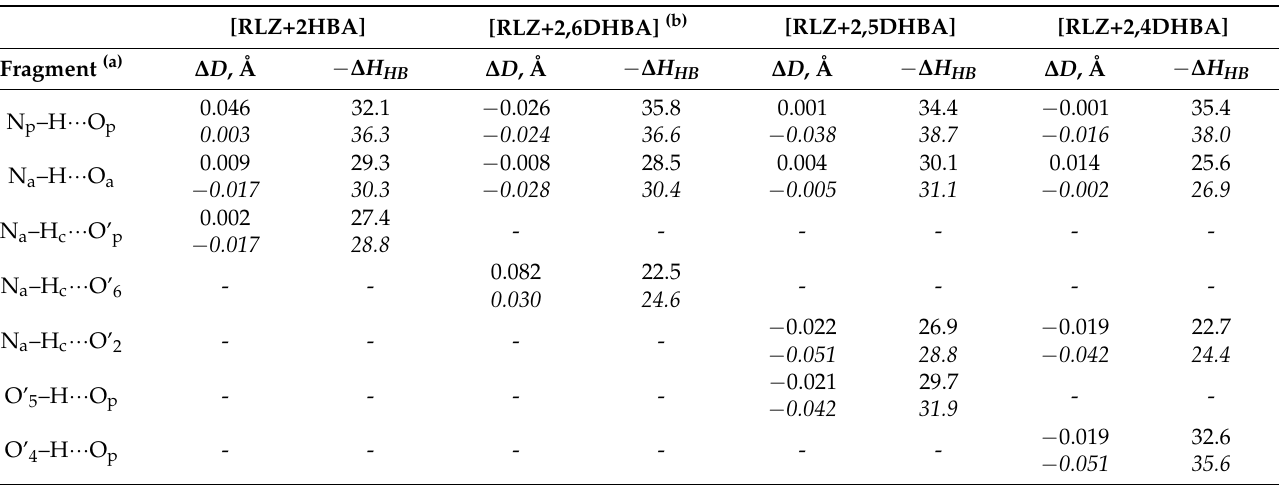
Figure 2. Fragment of the hydrogen bond network in crystalline [RLZ+2,4DHBA] (1:1). H-bonds are shown as dotted lines. Numbers indicate the enthalpies of intermolecular H-bonds estimated using Equation (1) at the PBE-D3 level. Table 1. The difference between the calculated (B3LYP/6-31G** and PBE-D3/6-31G**) and experi- mental values of the distances between heavy atoms ∆ D in the considered crystals. The enthalpies ∆ H · mol − 1 ) of these H-bonds, evaluated using the Rozenberg approach, see Equation (1). The HB (kJ PBE-D3 values are given in